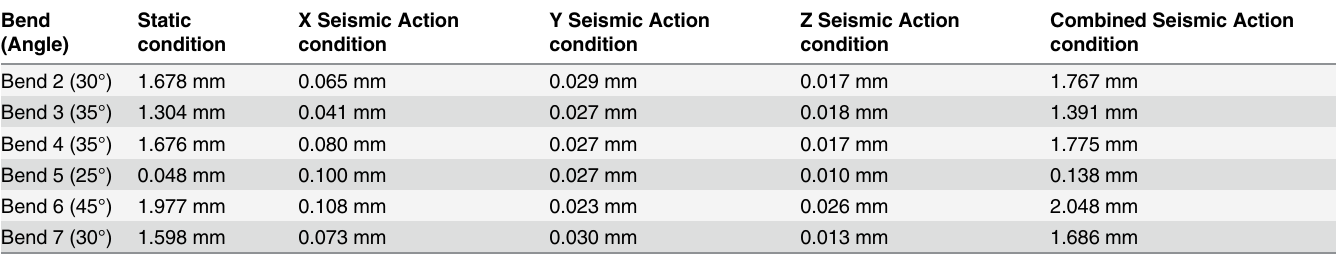
Table 12. Comparison of longitudinal displacements of different bends (25° – 45°) under different working conditions. Bend Static X Seismic Action (Angle) condition condition